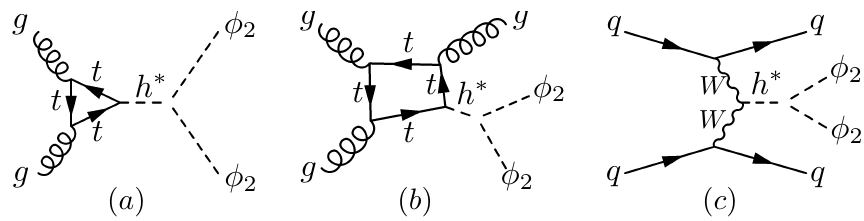
Figure 7 . Various productions modes for the Higgs-portal modes. Diagrams (a) and (b) show the pair production of (cid:30) 2 through the top-loop higgs production, while diagram (c) is through the VBF higgs production.